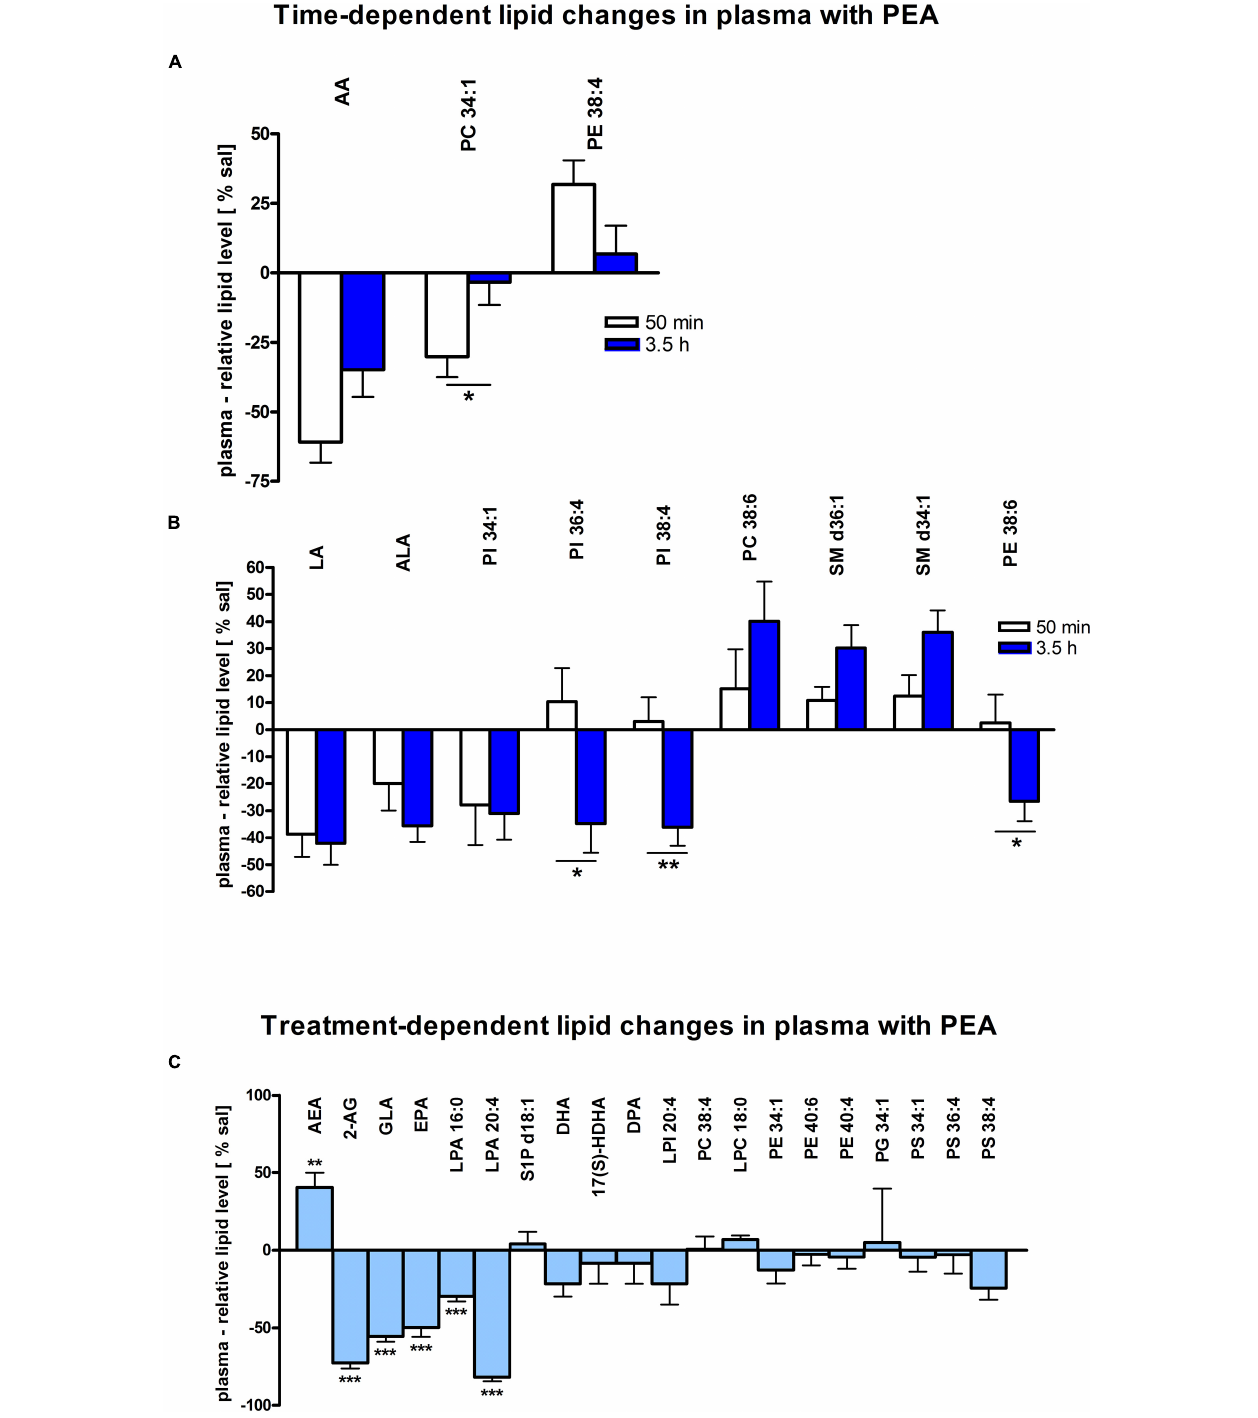
FIGURE 3 | Lipid levels of plasma after PEA treatment. Relative lipid concentrations (normalized to ml plasma: 40 µ l) after PEA treatment as percentage of saline treated mice are shown and presented as mean value ± SEM. (A) Time point 1: time-specific lipid plasticity after 50 min of PEA treatment. Relative lipid levels for two different time points are shown and only lipids significantly changing after 50 min of PEA treatment are depicted. (B) Time point 2: time specific lipid plasticity after 3.5 h of sub-chronic PEA treatment. Relative lipid level for two different time points are shown and only lipids significantly changing after 3.5 h of PEA treatment are depicted. Significant differences between the time points were also detected and as they underline time specificity for these lipids, they were marked on the figure with ∗ . (C) Merged time points: PEA treatment effect on lipid plasticity. Changes for AA, PI 38:4, SM d36:1 and PE 40:6 are significant when pooling the time points. The remaining significantly changed lipids show significant changes for both time points, respectively. Data were considered significant at a p -value < 0.05, e.g., ∗∗∗ p < 0.001, ∗∗ p = 0.001 to 0.01; ∗ p = 0.01 to 0.05.